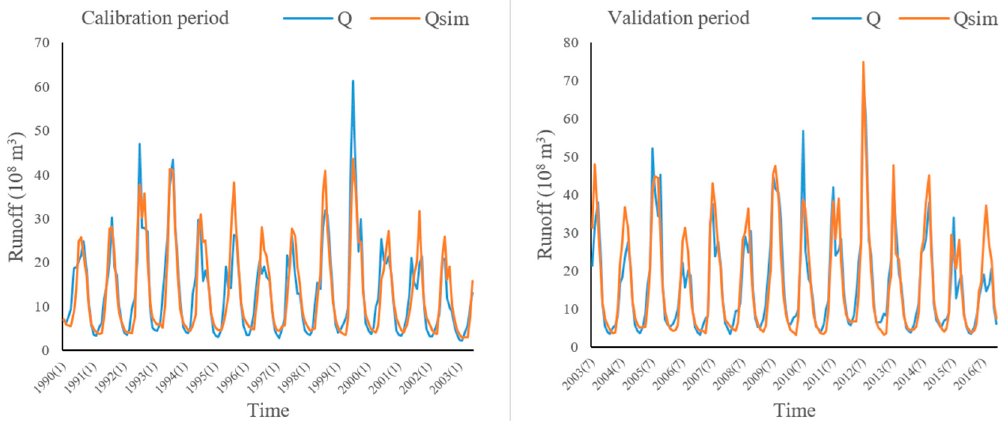
Figure 7. Monthly runoff simulation results in the post ‐ change period using the monthly ABCD model.